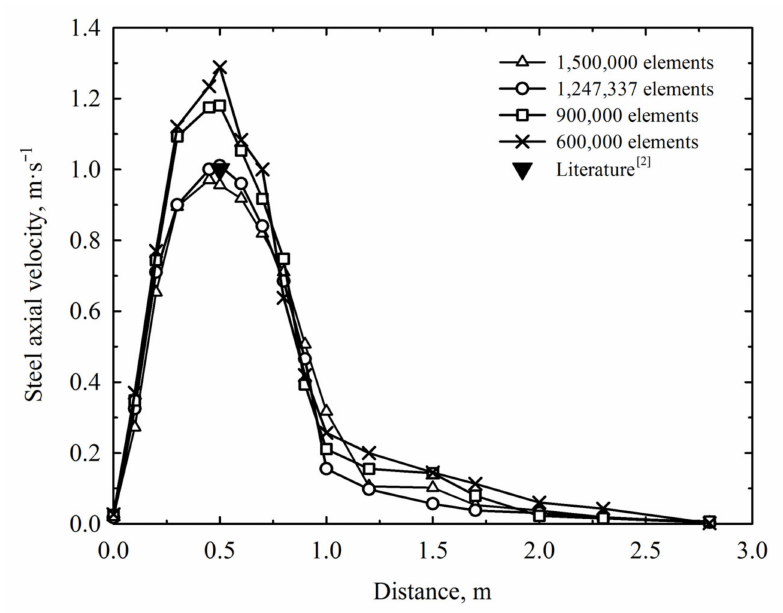
Figure 3. Mesh sensitivity analysis through steel axial velocity and literature